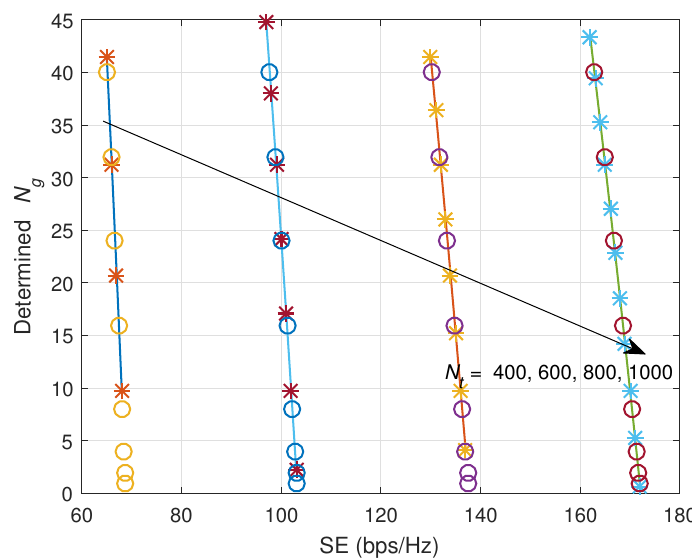
Figure 9. Determined N g versus guaranteed SE (bps/Hz) when MF precoding is applied. ‘*’ marks indicate results of closed-form SE equation, and ‘O’ marks indicate results of MC simulations.